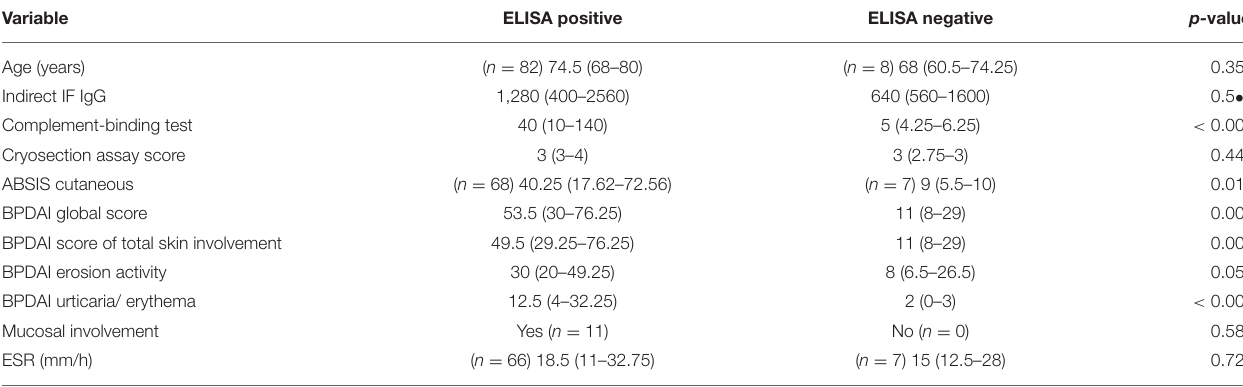
TABLE 1 | Values of different clinical and immunopathological variables according to ELISA positivity (*). Variable ELISA positive ELISA negative